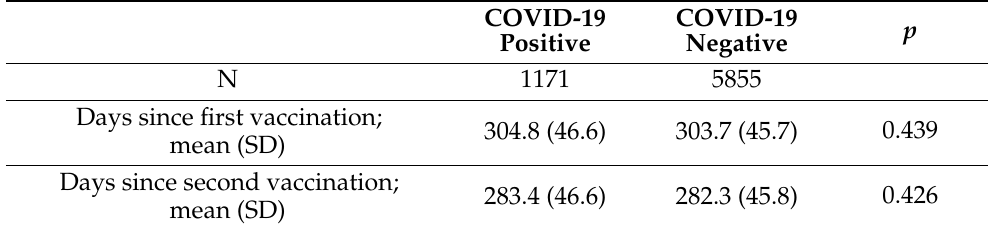
Table 2. Demographic and clinical characteristics of the study population after